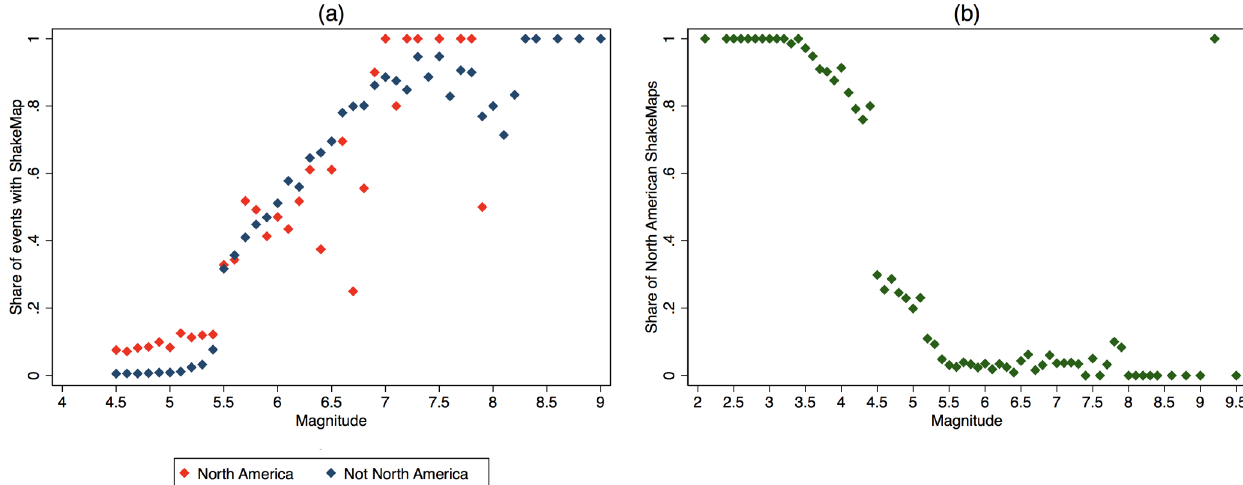
Figure C5. The share of events with ShakeMap (a) and the share of North American ShakeMaps (b) by magnitude for events since 1973. Below magnitude 5.5 ShakeMaps for North American events are more commonly produced, and below magnitude 4.5 they are almost exclusively produced for North American